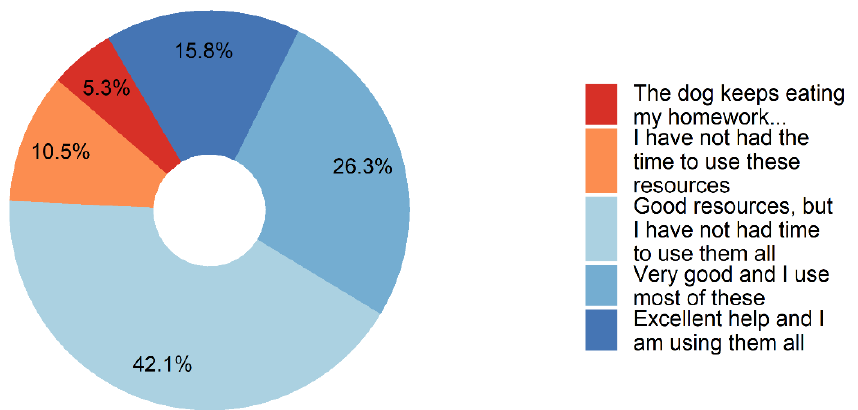
Figure 2. Survey results on the usefulness of example playbooks (source: based on the polling survey results).